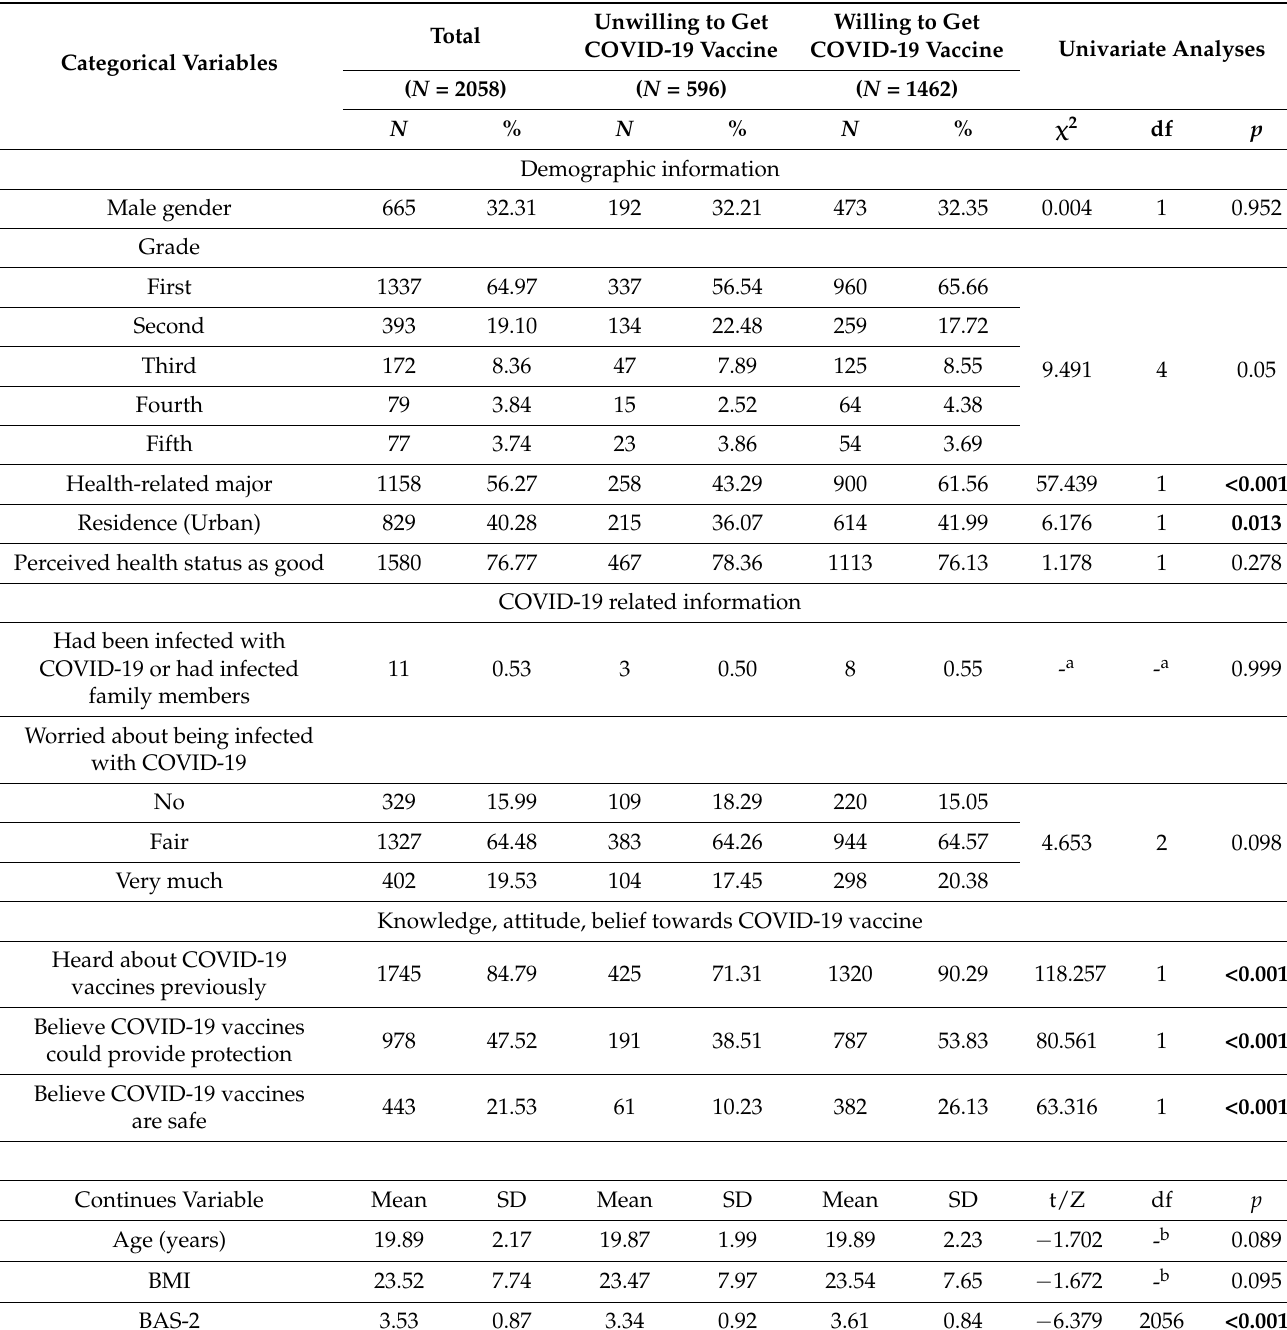
Table 1. Differences between students who are willing versus unwilling to receive a COVID-19 vaccine in the future.